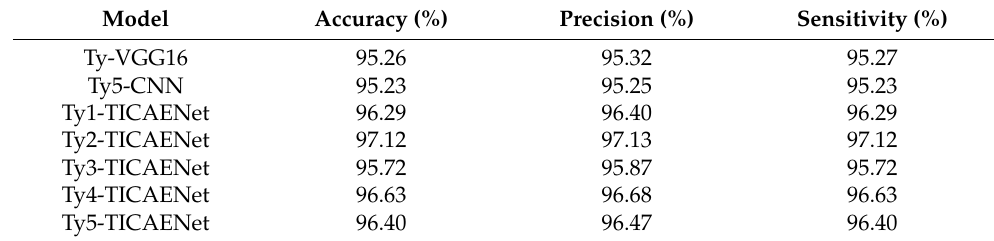
Table 6. Accuracy, precision and sensitivity for six TC categories using various